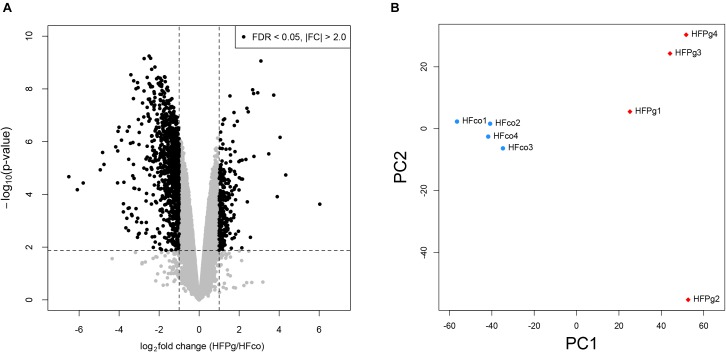
Microarray analysis in the liver between HFco and HFPg mice (n = 4). (A) Volcano plots, (B) PCA analysis.